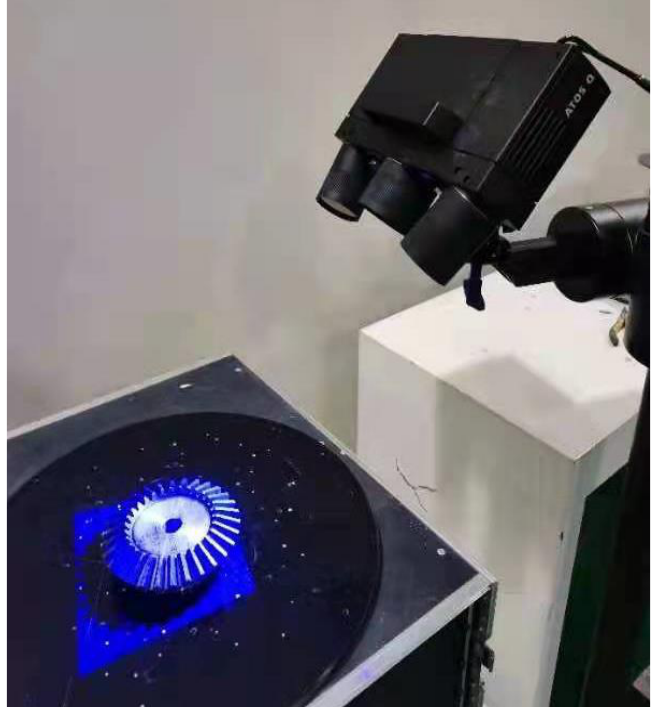
Figure 9. Equipment used for gear data collection.